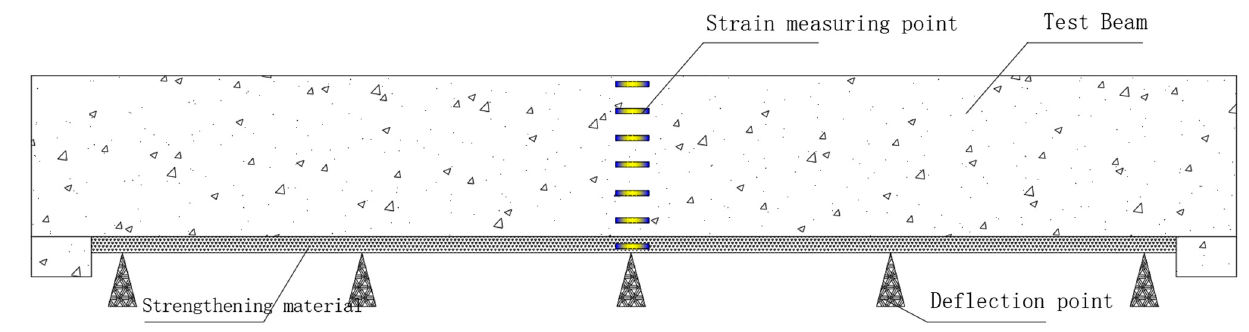
Figure 4. Layout diagram of strain and deflection measurement points.